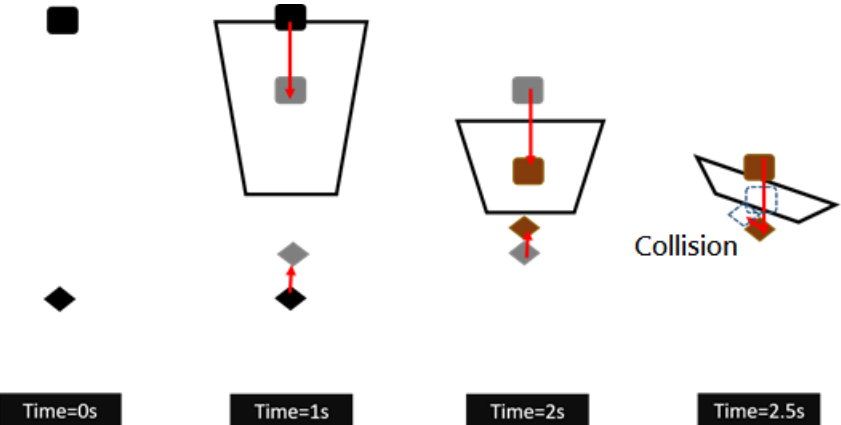
Figure 11. Schematic diagram of collision between obstacles and robots.